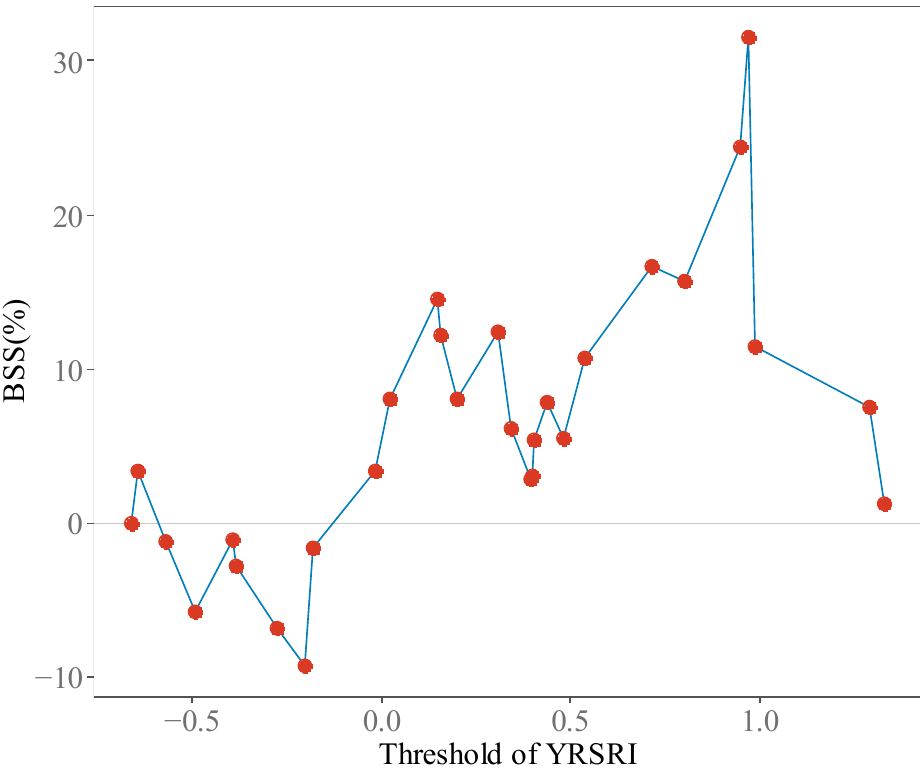
Figure 7. Brier skill score (BSS) of the forecast for different thresholds of the Yangtze River Valley summer rainfall index (YRSRI) based on WPSHI(R).